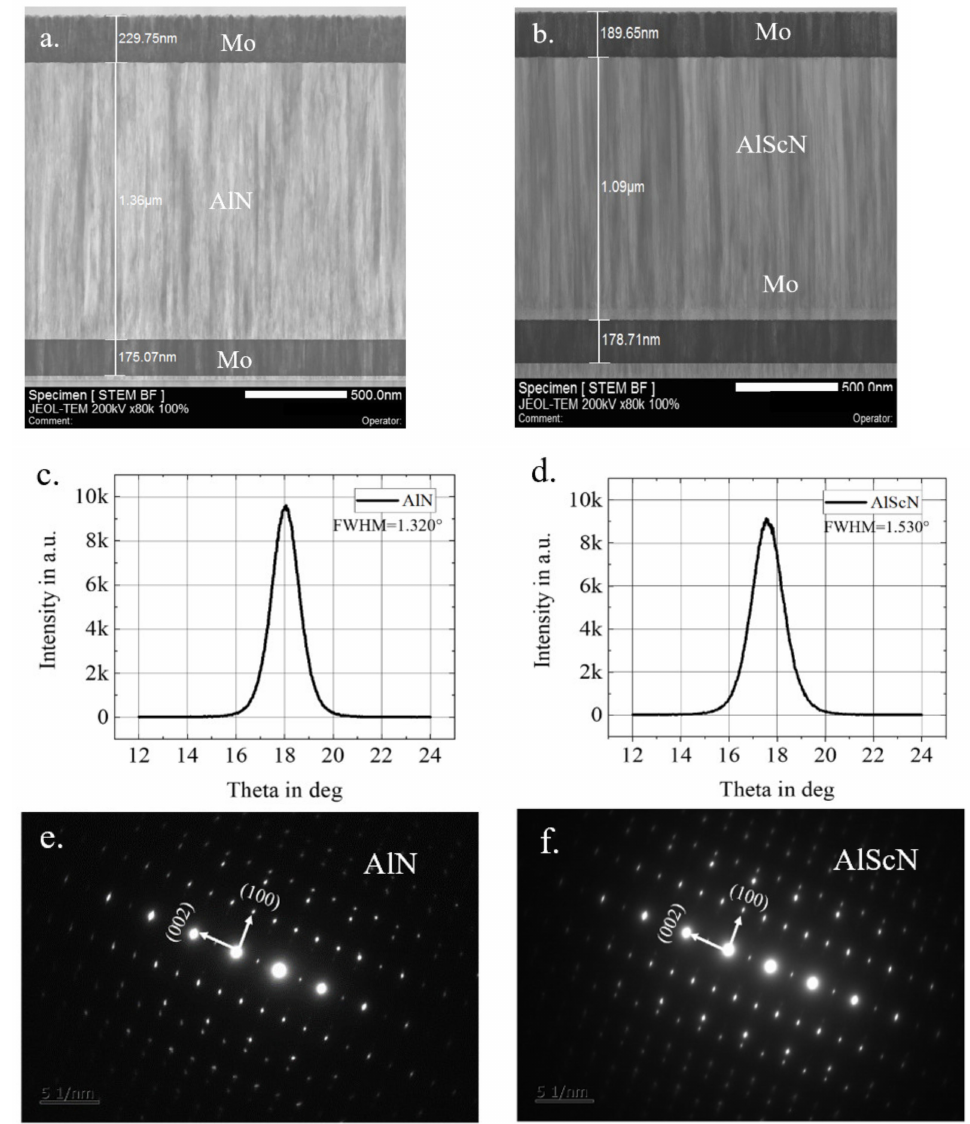
Figure 2. ( a ) Scanning transmission electron microscopy (STEM) image of the Mo-AlN-Mo structure; ( b ) STEM image of the Mo-AlScN-Mo structure; ( c ) Rocking curves of the AlN film; ( d ) rocking curves of the AlScN film; ( e ) selected area diffraction (SAD) pattern of AlN; ( f ) SAD pattern of